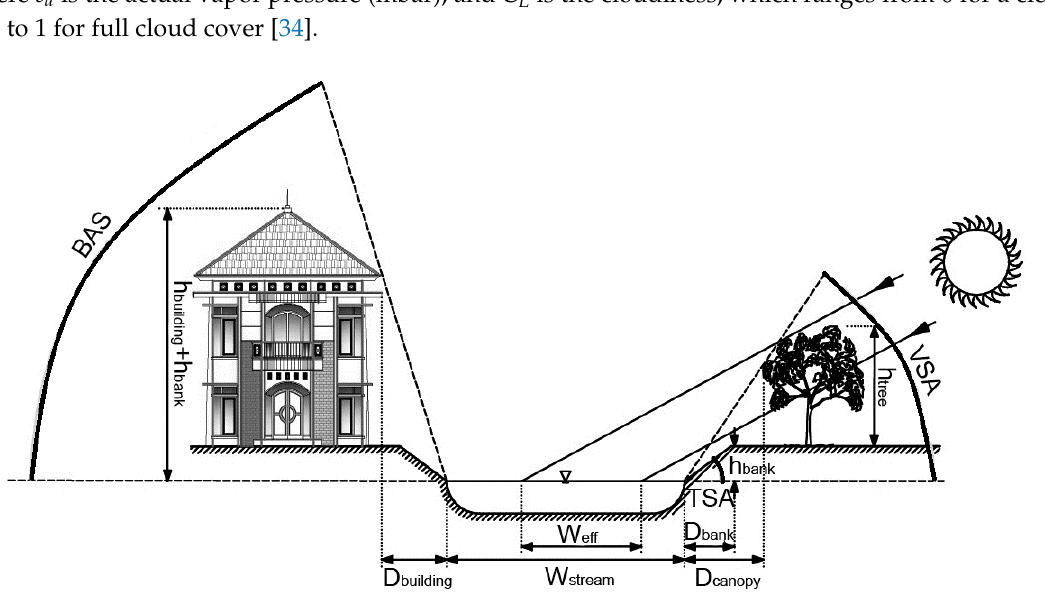
Figure 1. Shading of the river surface. A cross-sectional view, in which BSA is the building shading angle, VSA is the vegetation shading angle, and TSA is the topographic shading angle. h building , h tree , and h bank are building, vegetation, and bank heights respectively. D building , D canopy , and D bank are building to the bank, canopy to the bank, and bank.